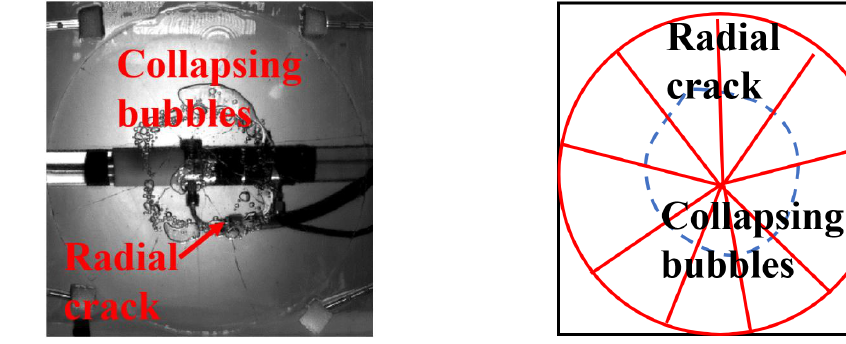
Figure 11. Radial cracks pattern when H = 1.49, T = 0.28.